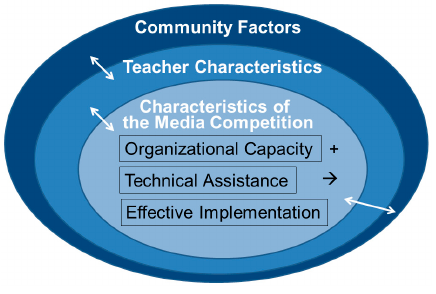
Figure 1. Ecological Framework for Understanding Effective Implementation of the Media Competition. Adapted from [1].